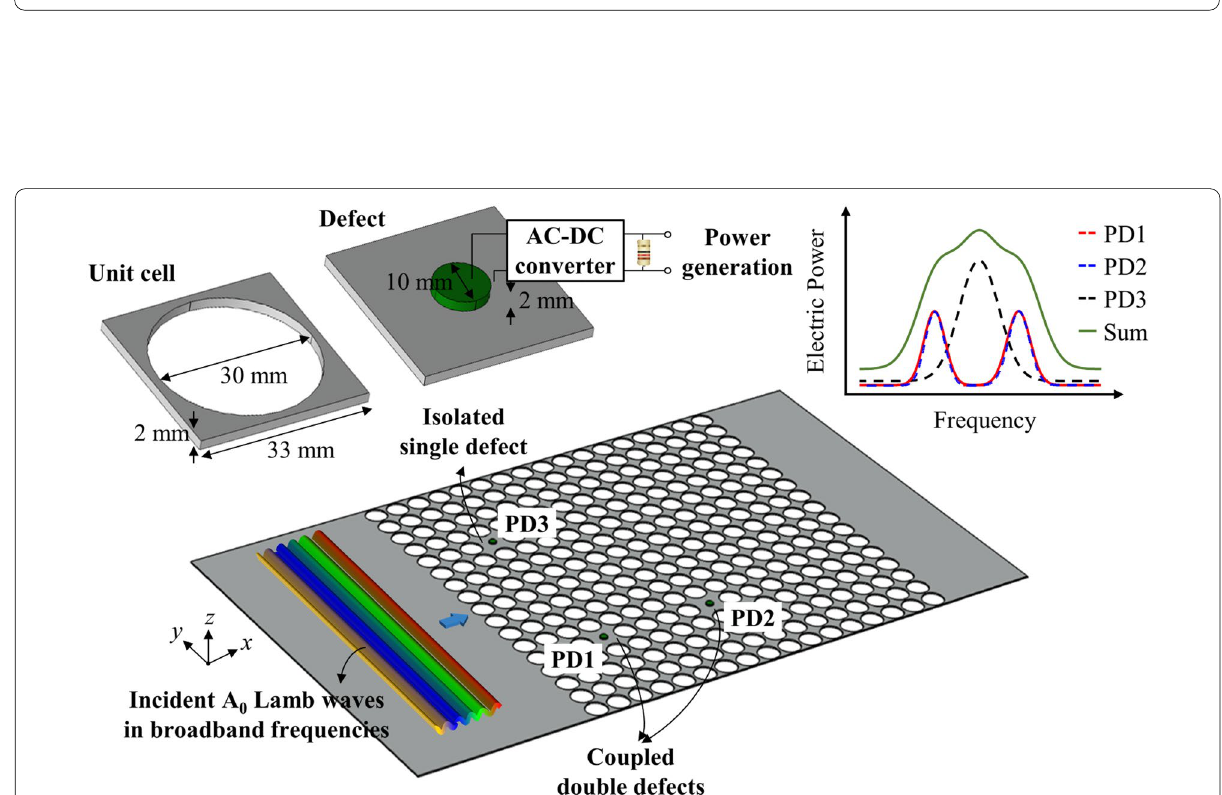
Fig. 2 A schematic illustration of the proposed PnC design with L‑shape triple defects (PD1, PD2, and PD3) for broadband energy localization and harvesting, relative to right‑going incident plane A 0 Lamb